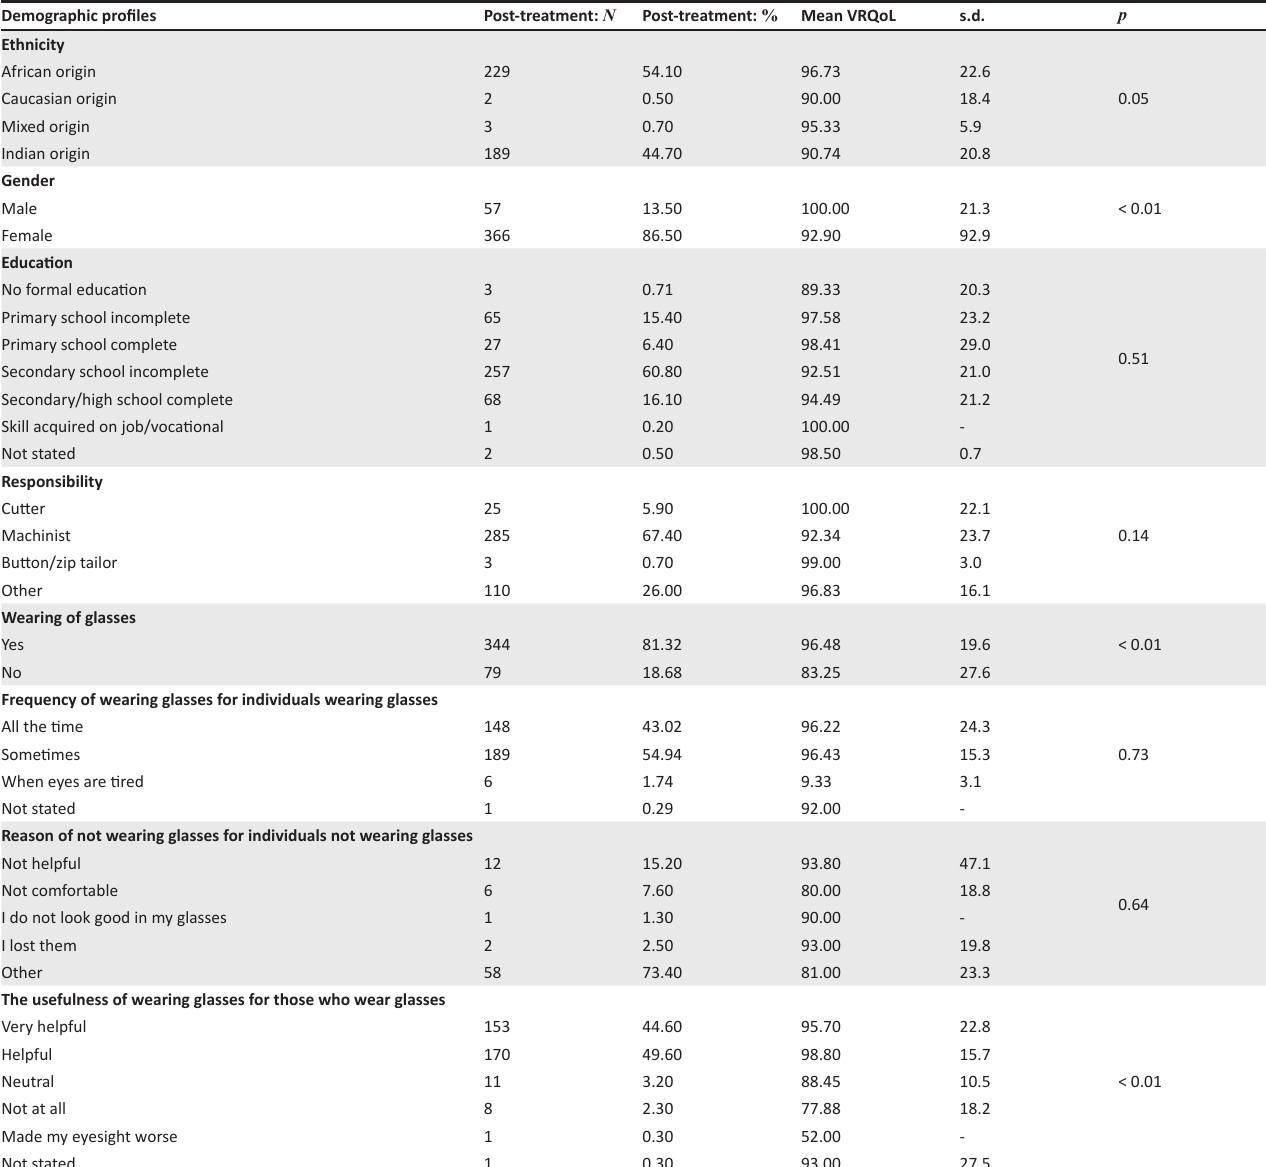
TABLE 2: Follow-up mean vision-related quality of life score of the 423 participants. Demographic